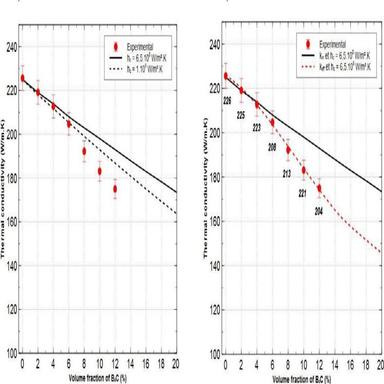
TC of Al/B4C composites at 30 °C with different B4C contents. Experimental points fitted with (a) the Hasselman-Johnson model and (b) the modified Hasselman-Johnson model.